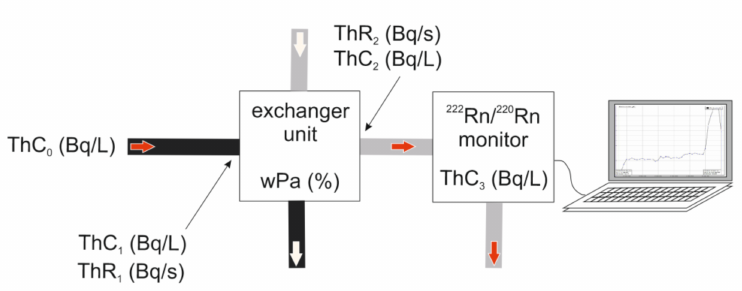
Figure 4. Illustration of the experimental approach as discussed in the